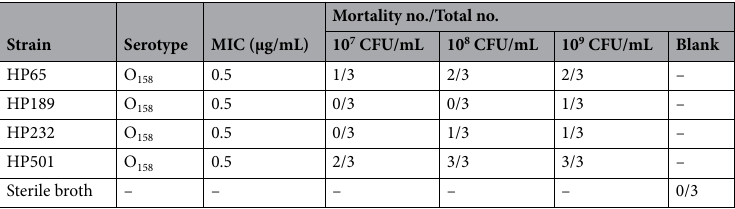
Table 1. The results of E. coli virulence test for mice.